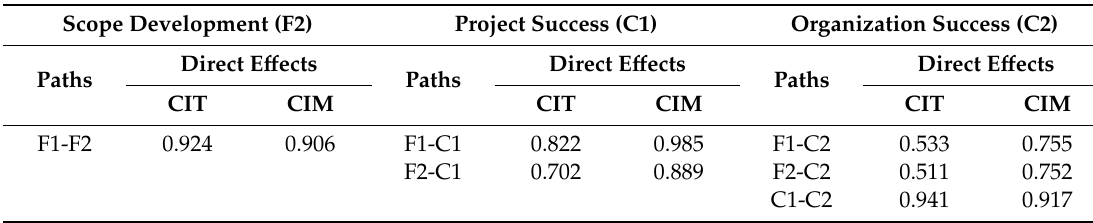
Table 22. Direct e ff ects measurements.